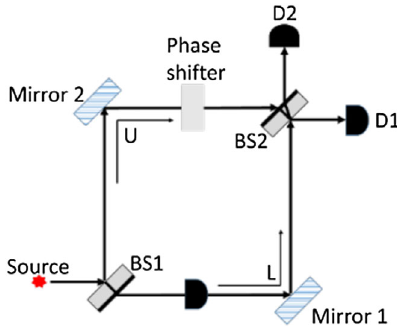
FIG. 3. MZI setup with an additional detector placed in the L